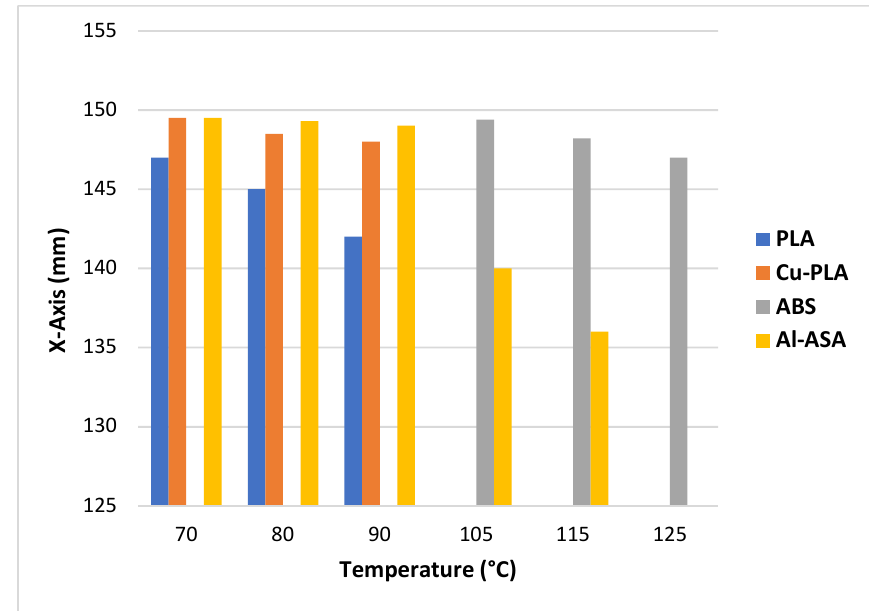
Figure 5. Dimensional change in x -axis.